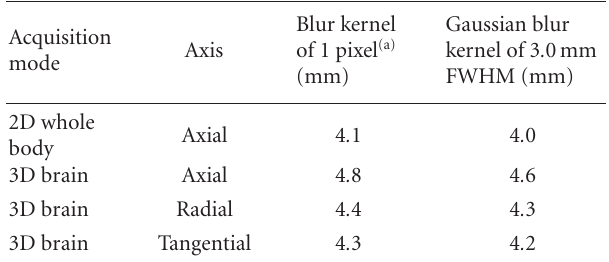
Table 4: Lesion target-to-background ratios for the PET signals in the 2D whole-body mode acquisition patient